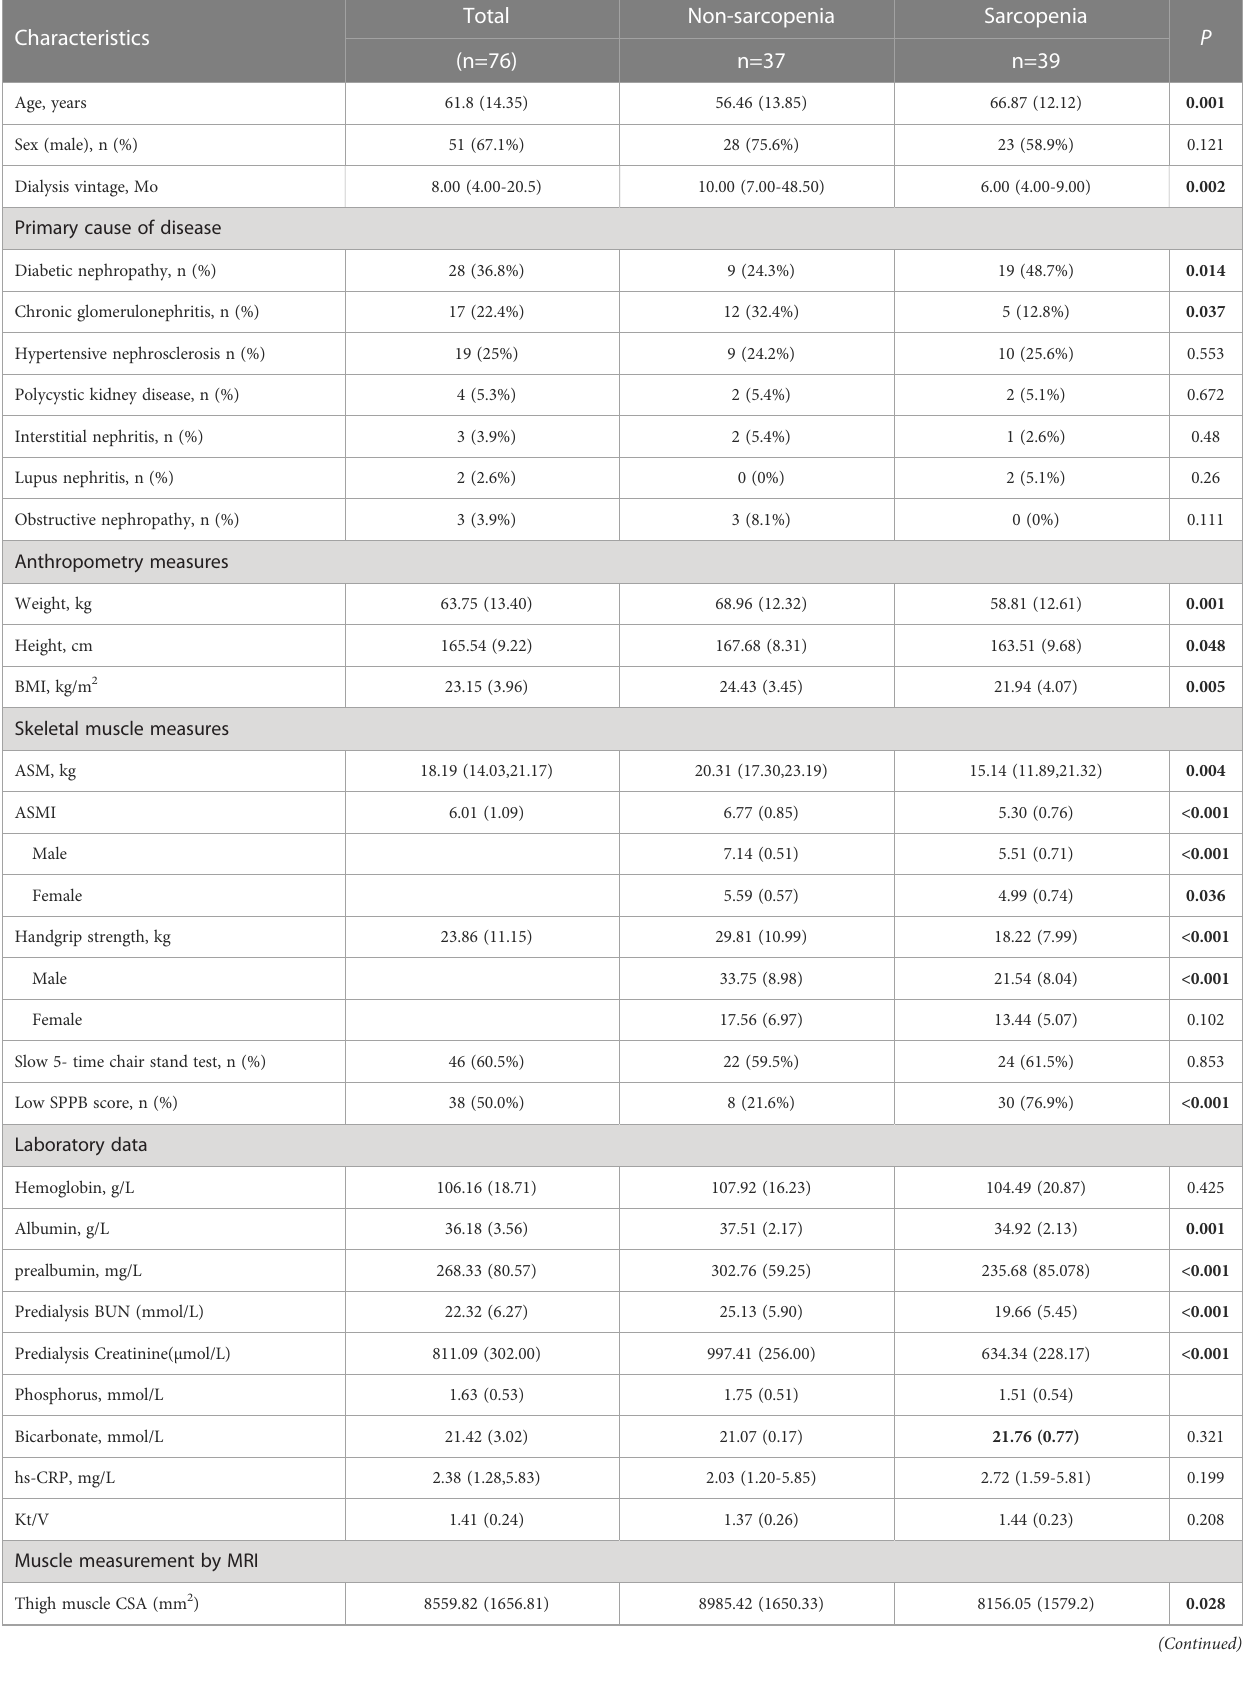
TABLE 1 Characteristics of the hemodialysis patients in the sarcopenia and the non-sarcopenia group.